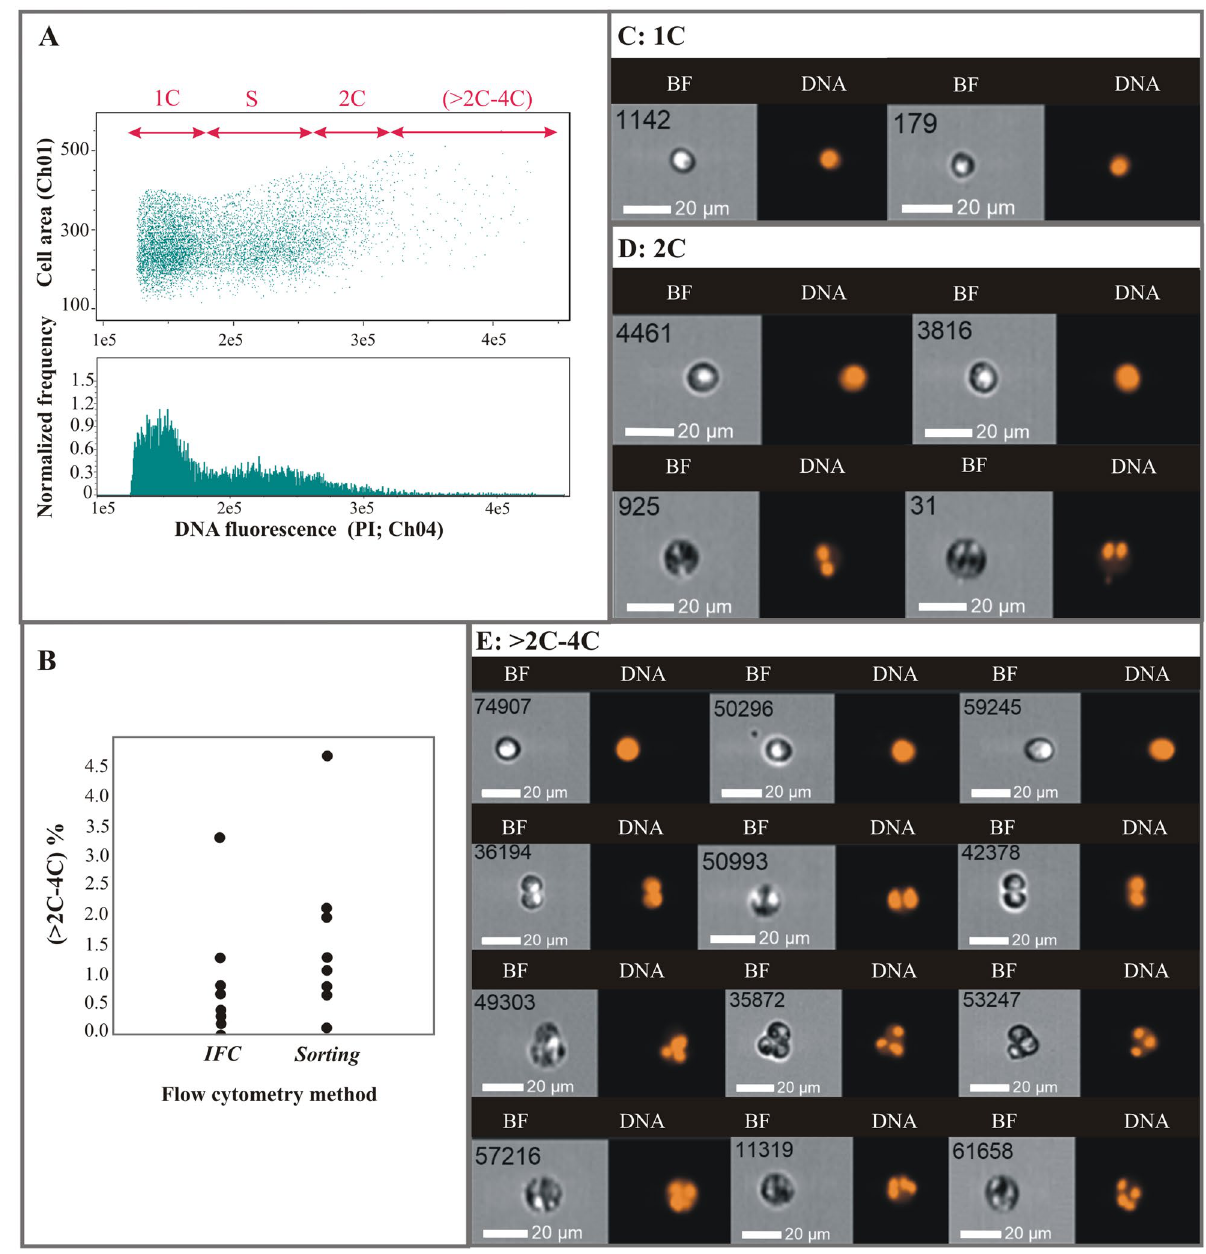
Figure 3. Imaging Flow Cytometry (IFC) results. ( A ) Summary of the categories and delineation process for classifying Symbiodiniaceae cells according to DNA content (representative data from preliminary sample 10 is displayed) and representative images of each DNA content stage ( C – E ), where “BF” indicates Bright Field and “DNA” refers to DNA staining. ( B ) Percentage (%) of (> 2C–4C) cells in samples analyzed with IFC versus conventional cytometry (Sorting). ( C ) Cells within the 1C DNA content gate that have a single nucleus. ( D ) Cells within the 2C DNA content gate that have either one nucleus (first row) or two nuclei (second row). ( E ) Cells in the (> 2C–4C) DNA content group, grouped in rows according to the number of nuclei: 1 (first row), 2 (second row), 3 (third row) and 4 (fourth